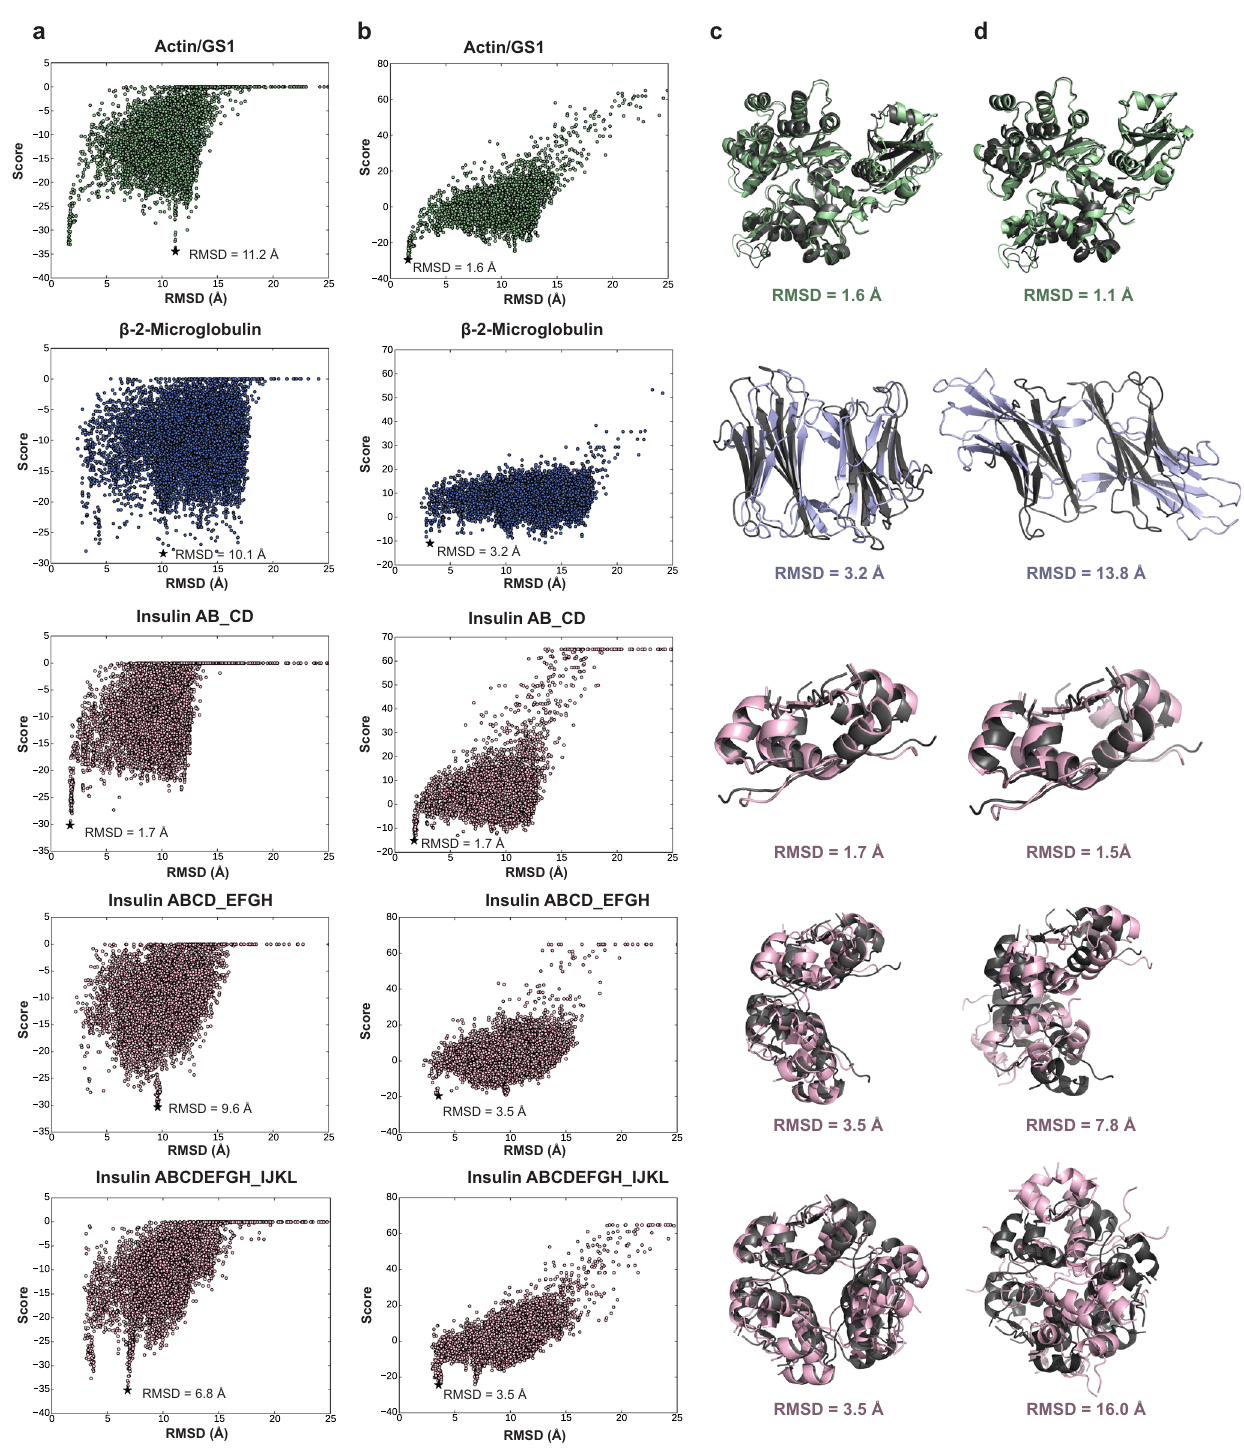
Fig. 2 | Score vs. RMSD to the crystal structure for 10,000 docked models generatedforeachcomplexinthebenchmarkset usingAlphaFold2modelsas docking input. The top-scoring models are marked by a black star and aligned to the crystal structure. Actin/gs1 is shown in green, β − 2-microglobulin in blue, and insulin structures in pink. The RMSD of the top-scoring model is indicated next to the marked point. a RosettaDock Isc versus RMSD (without CL data). b Covalent